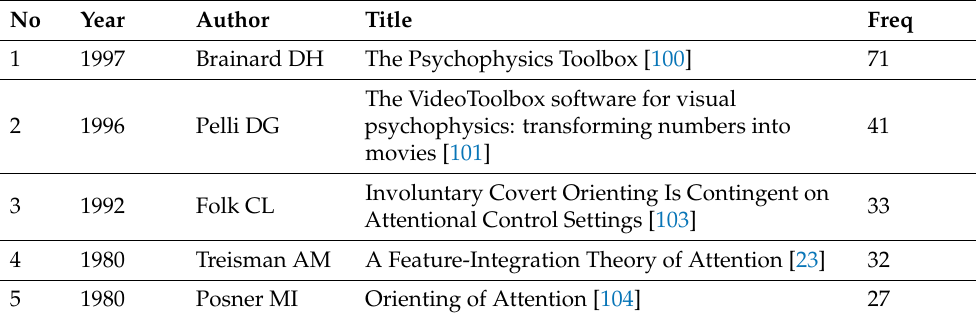
Table 4. Top 5 most cited references of network for the first step of the review, visual